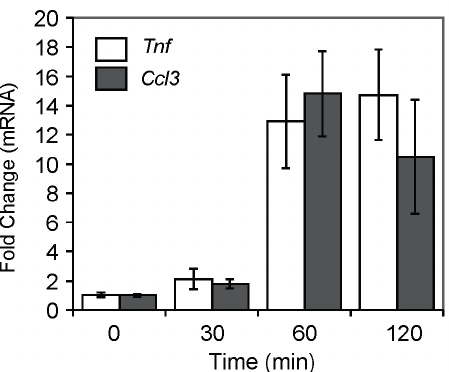
Figure 3. Expression of inflammatory mediators induced by 8-oxoG base challenge. Eight-week-old female Balb/c mice were used for these studies. Mice ( n = 5–6) were challenged i.n. under mild anesthesia with 60 µL of pH (7.4) balanced saline solution containing 50 ng per kg 8-oxoG, or only saline [68]. After 0, 30, 60 and 120 min of exposure, lungs were removed, and RNAs were isolated. After reverse transcription, mRNA levels of selected cytokines were determined using individual primer pairs. qRT-PCR was performed in an ABI7000 Sequencer, and expression levels were calculated by the ΔΔ C t method [106,107]. Animal experiments were performed as described in the legend to Figure